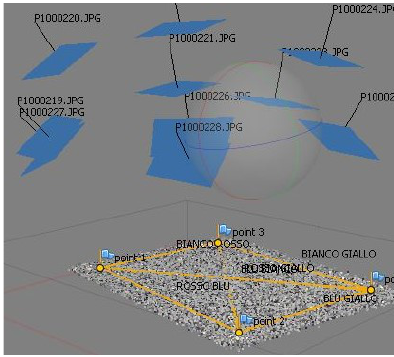
Figure 2. Photogrammetric in situ survey of an asphalt area.